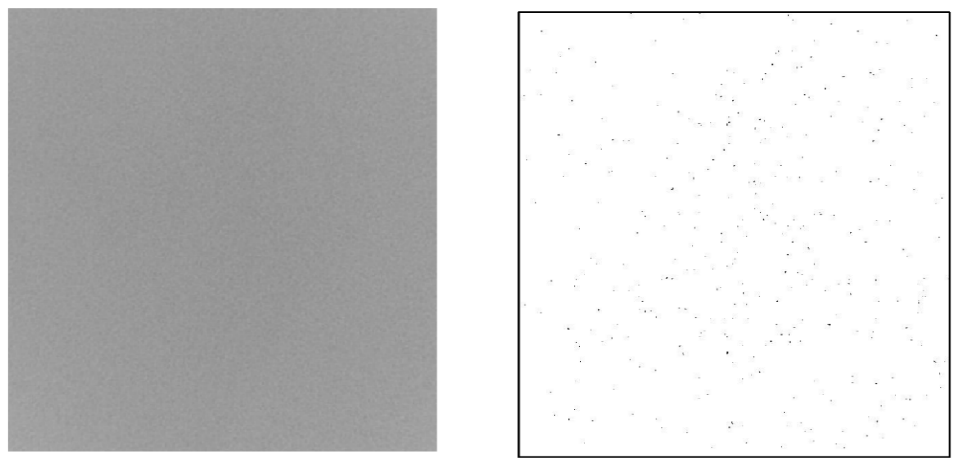
Figure 24. Final version of artificial image with no pore ( Left ) vs. binarized artificial image ( Right ). Experimenting with different sensitivity factors between 0.63 to 0.74 resulted in the following binary images with different percentages of porosity as shown in Figure 25.